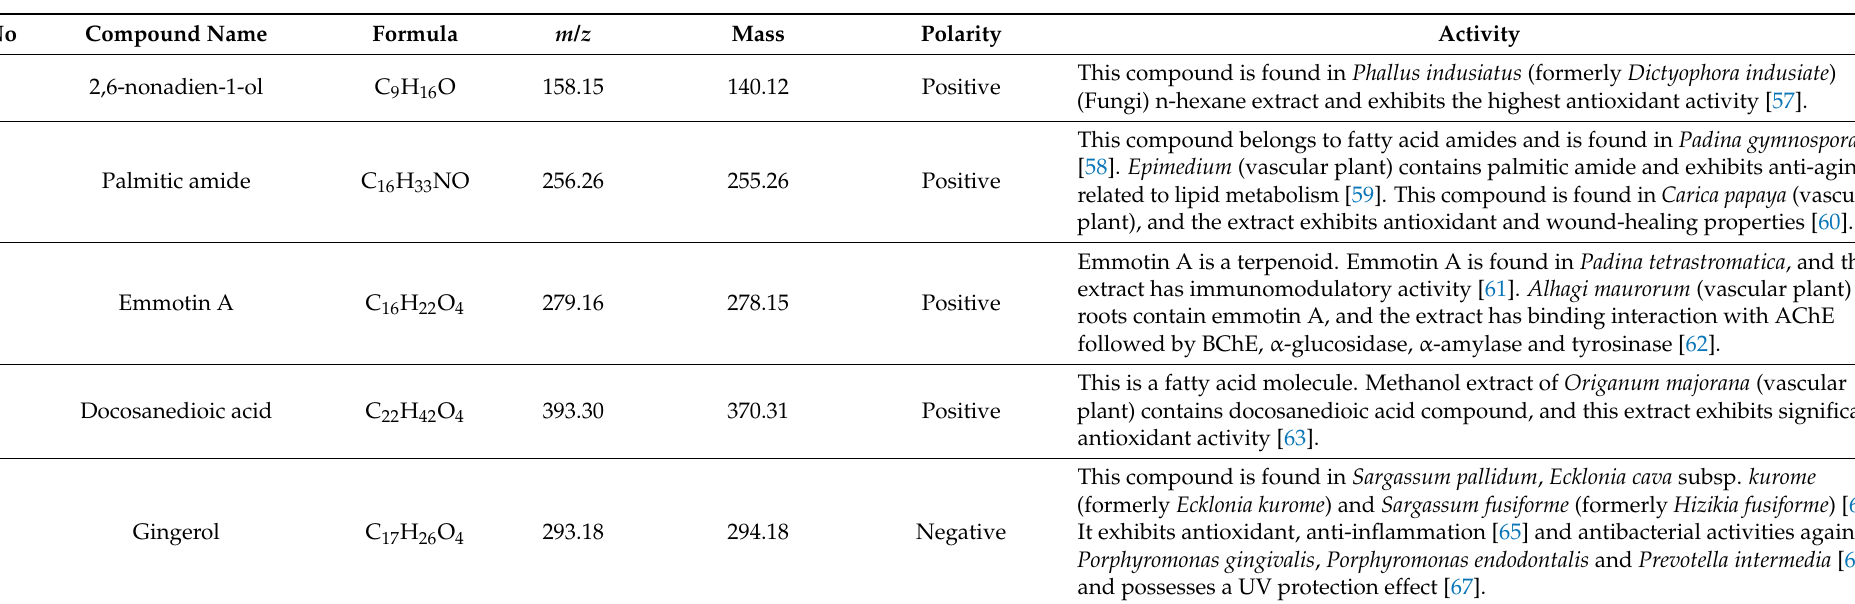
Table 4. Predicted compounds in the P. australis water extract identified through LC-MS